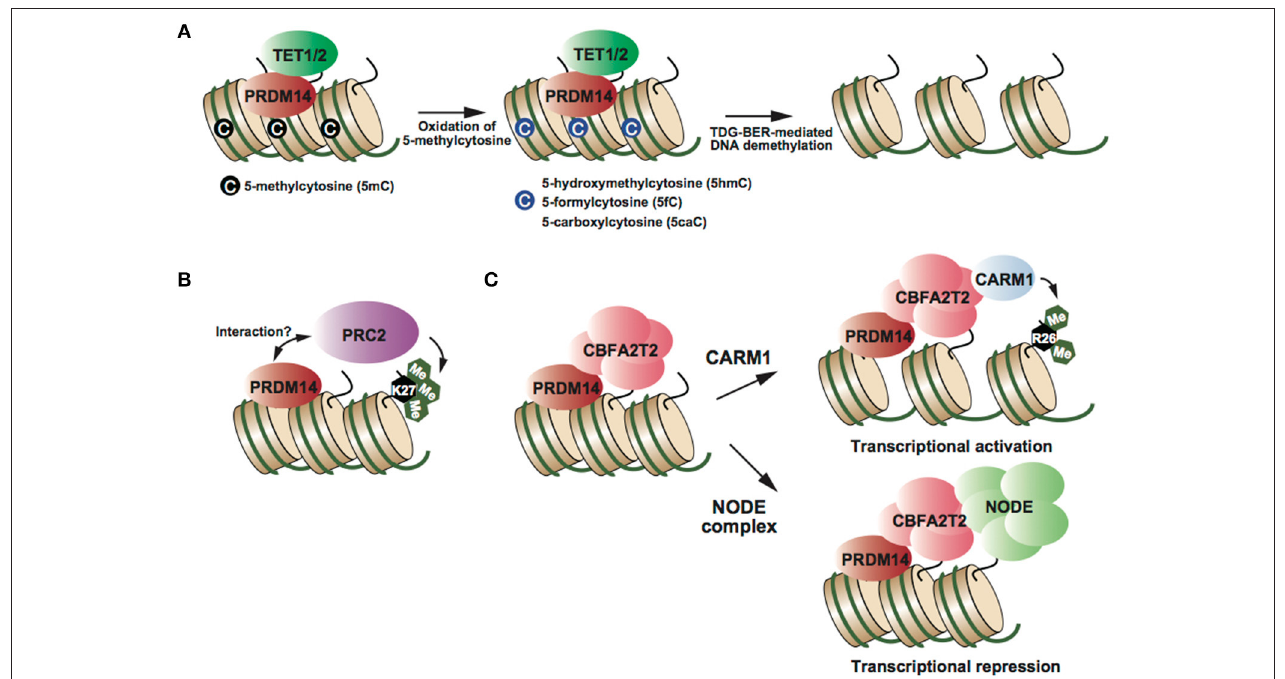
FIGURE 2 | (A) PRDM14 recruits TET proteins at target genes, resulting in oxidation of 5mC and TDG-BER-mediated demethylation (Okashita et al., 2014). (B) PRDM14 might interact with PRC2 and its complex deposits H3K27me3, resulting in transcriptional repression (Yamaji et al., 2013). (C) CBFA2T2 is an essential partner of PRDM14 in both transcriptional activation and repression ( Nady et al., 2015; Tu et al., 2016). Partner switching of the PRDM14-CBFA2T2 complex depending on target genes ( Burton et al., 2013; Nady et al.,